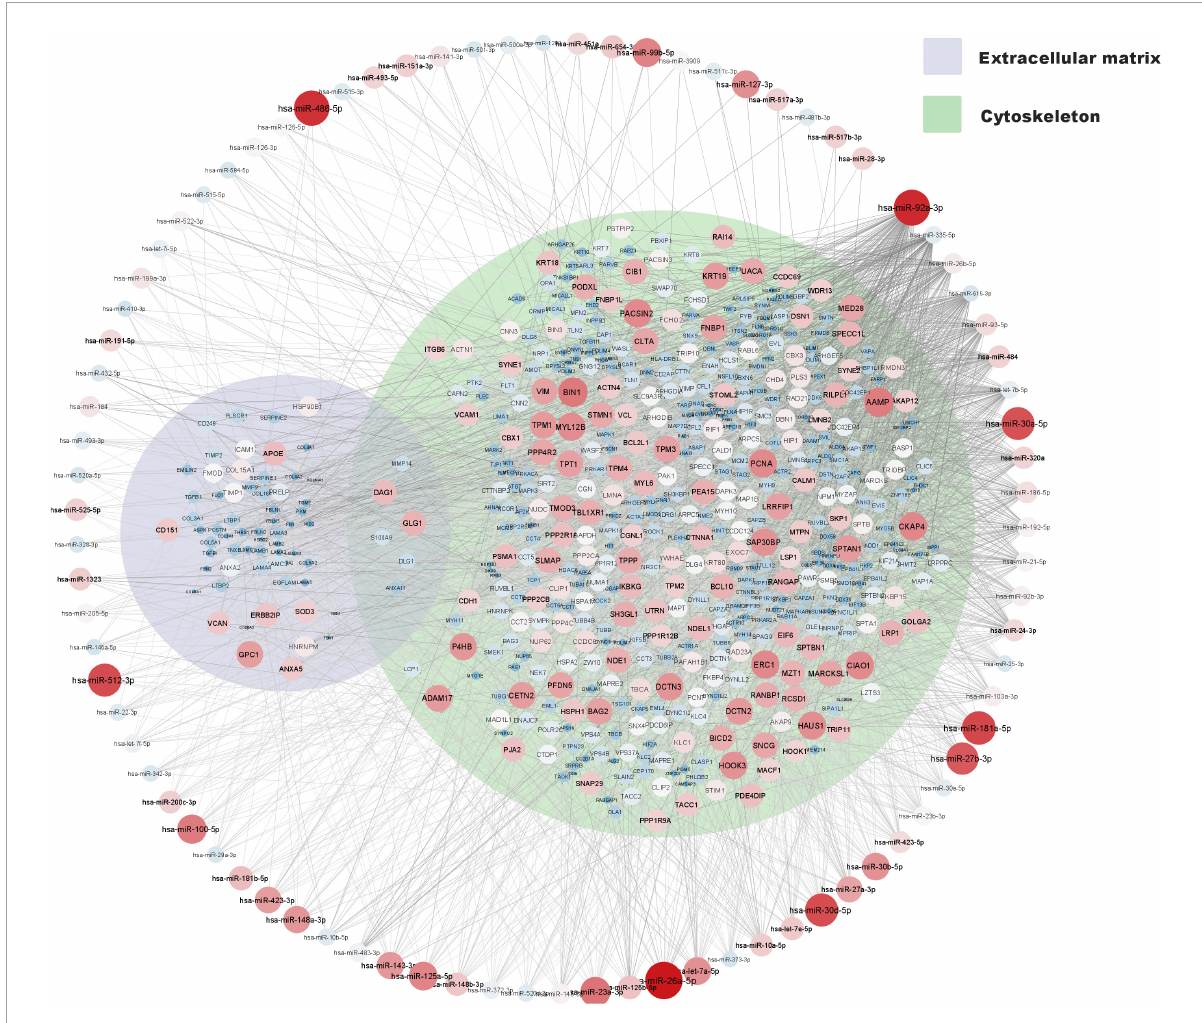
FIGURE3 miRNA and protein expression levels annotated to structural integrity in placenta. Normalised expression levels of miRNAs with a z -score above zero and proteins are illustrated on a continuous scale from lowest expression (bluer smaller nodes) to highest expression (redder larger nodes) and the miRNA target links (edges) to gene products sorted with respect to their degree of edges. Proteins annotated to cytoskeleton (GO: 0005856) and or extracellular matrix (GO: 0031012) are shown within their respective Venn-circular